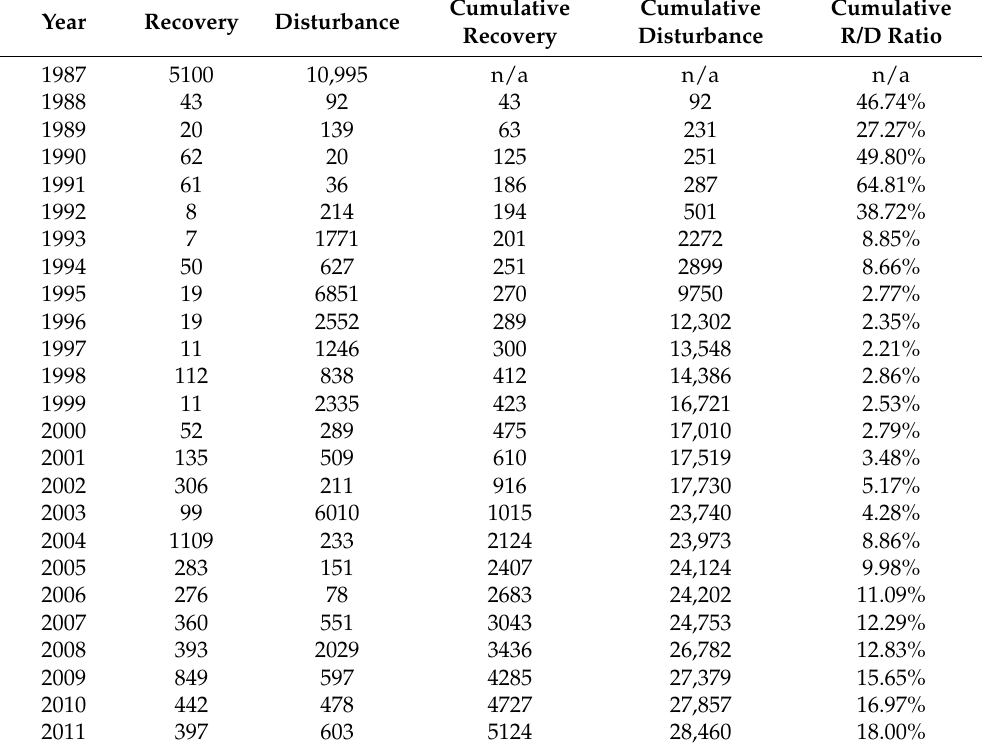
Table A1. The number of yearly and cumulative disturbed and recovery pixels from 1987 to 2020 in the western